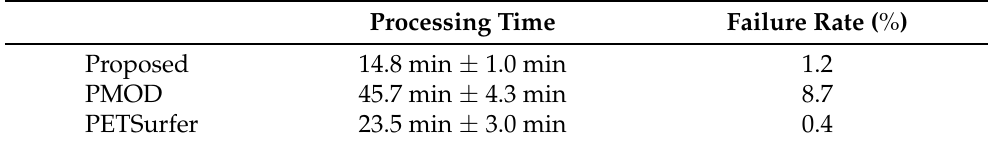
Table 6. Results of processing time and failure